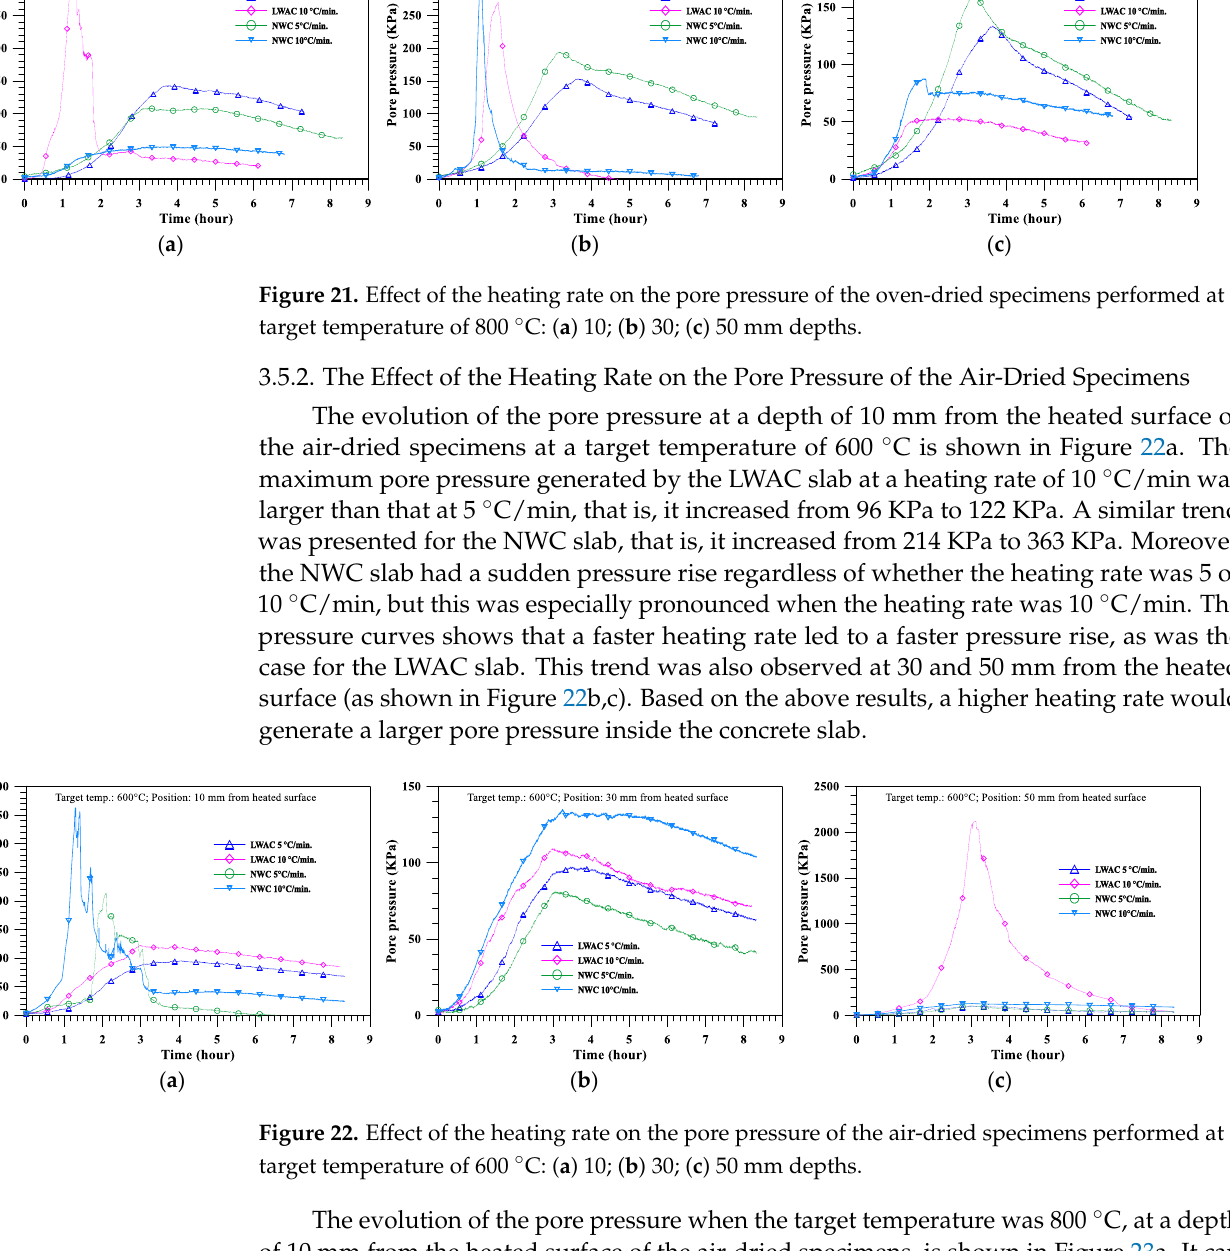
( b ) ( c ) Figure 23. Effect of the heating rate on the pore pressure of the air-dried specimens performed at a target temperature of 800 °C: ( a ) 10; ( b ) 30; ( c ) 50 mm depths. 3.6. The Effect of the Moisture Content on the Pore Pressure 3.6.1. Concrete Slabs Exposed to a Target Temperature of 600 °C The moisture content of a concrete specimen represents the mass percentage of the moisture it contains, which is closely related to the increase in the pore pressure at high temperatures [63]. The evolution of the pore pressure at a depth of 10 mm from the heated surface of the concrete slab, at a target temperature of 600 °C and a heating rate of 5 °C/min, is shown in Figure 24a. The LWAC slabs had similar pressure curves in the oven-